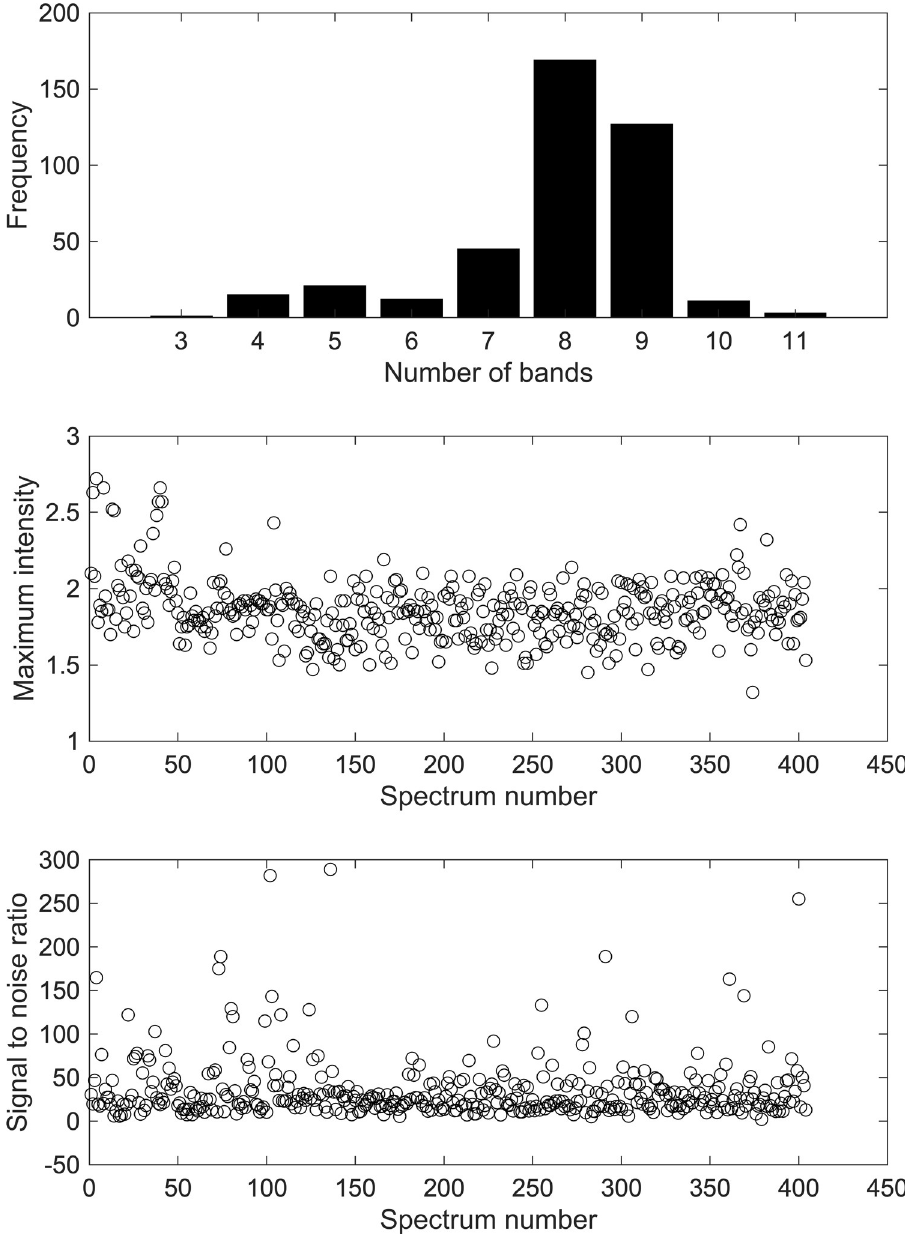
Fig 3. Histogram regarding the number of bands for the measured COVID-19 vaccines (top), maximum peak intensity of the different vaccines (middle) and signal to noise ratio of the vaccines (bottom).